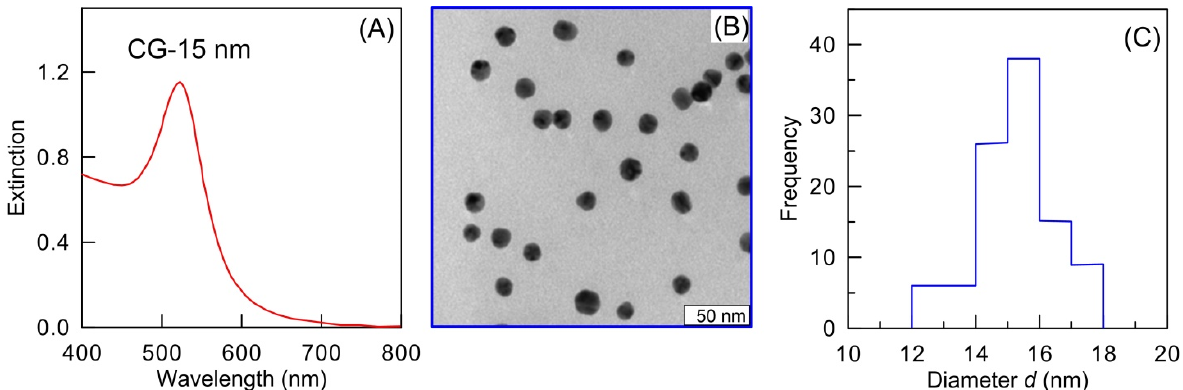
Figure 1. Characterization of GNPs: extinction spectrum ( A ), TEM image ( B ), and size distribution (DLS data) ( C ).